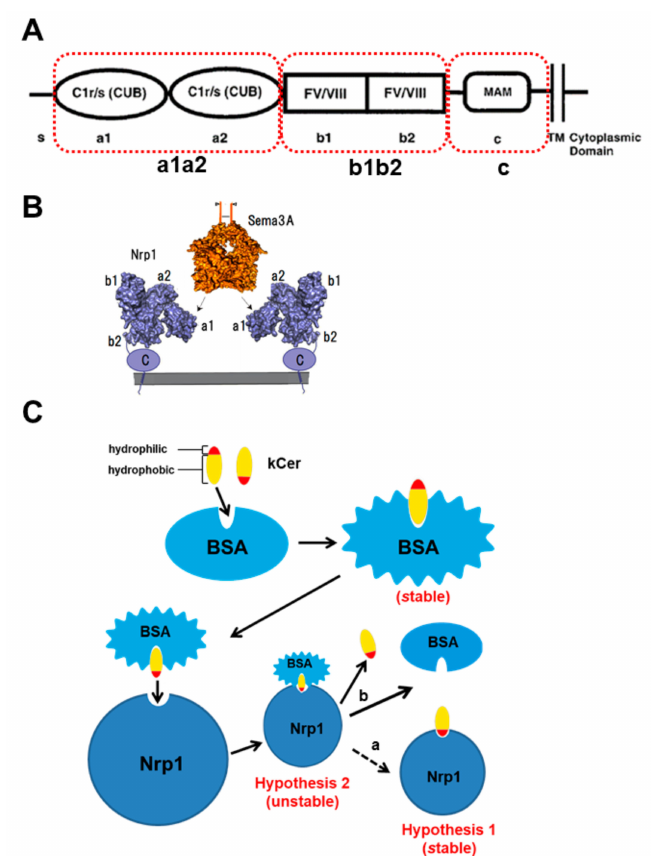
Figure 2. Structure of Neuropilin 1 (Nrp1) and the binding mechanism of semaphorin 3A (Sema3A). ( A ) Diagram displaying the modular structure of Nrp1, which is comprised of five domains (a1, a2, b1, b2, and c), as illustrated by He et al. [1]. S: signal peptide; C1r / s: complement (CUB); FV / VIII: regions homologous to coagulation factor V and VIII; MAM: a specific domain in transmembrane proteins. ( B ) Interaction between Sema3A and Nrp1. Sema3A binds to domain a1 of a1a2 via the Sema domain, the Ig-like domain, and the C -terminal basic tail, as well as to domain b1 via the C -terminal tail. Vascular endothelial growth factor (VEGF) and heparin bind to b1b2. ( C ) Proposed model for kCer binding to Nrp1 as a Sema3A agonist based on the two hypotheses. a hydrophobic part of kCer binds to the fatty acid binding pocket, forming the kCer / BSA complex, which releases kCer via formation of the kCer / BSA / Nrp1 complex. kCer is indicated by a dashed arrow (a), representing a weak flow relative to the bold arrow